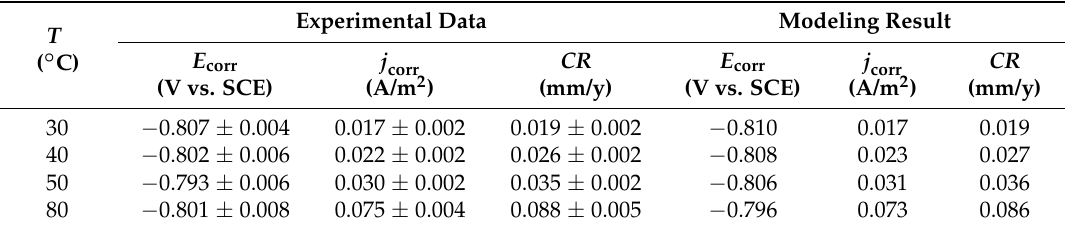
Table 3. The corrosion potential, corrosion current density and corrosion rate of Q345R steel in 1 wt.% NaCl solution with 0.08 mg/L oxygen at pH 6.0 under different temperatures, including the results fitted from the experiment data and calculated from the model.